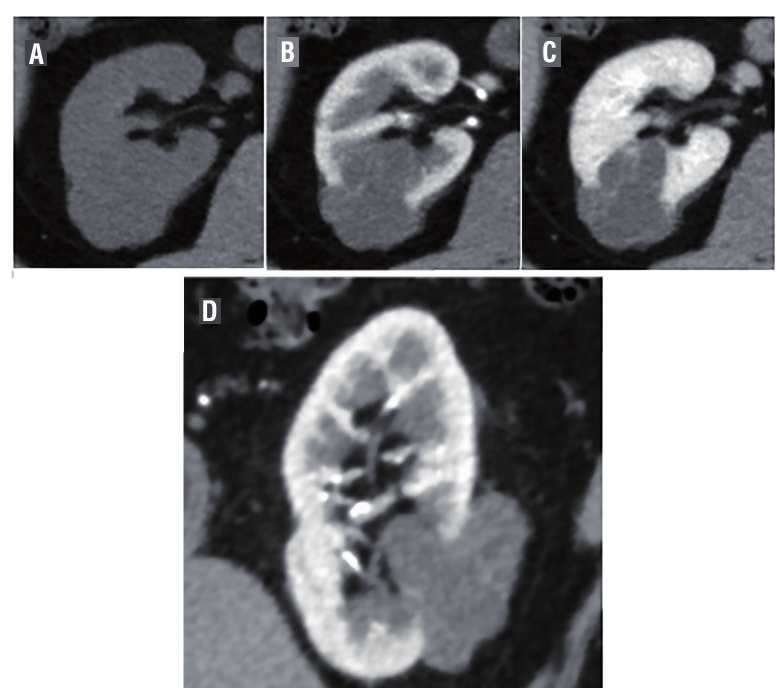
Figure 3 - Cystic pattern: Case